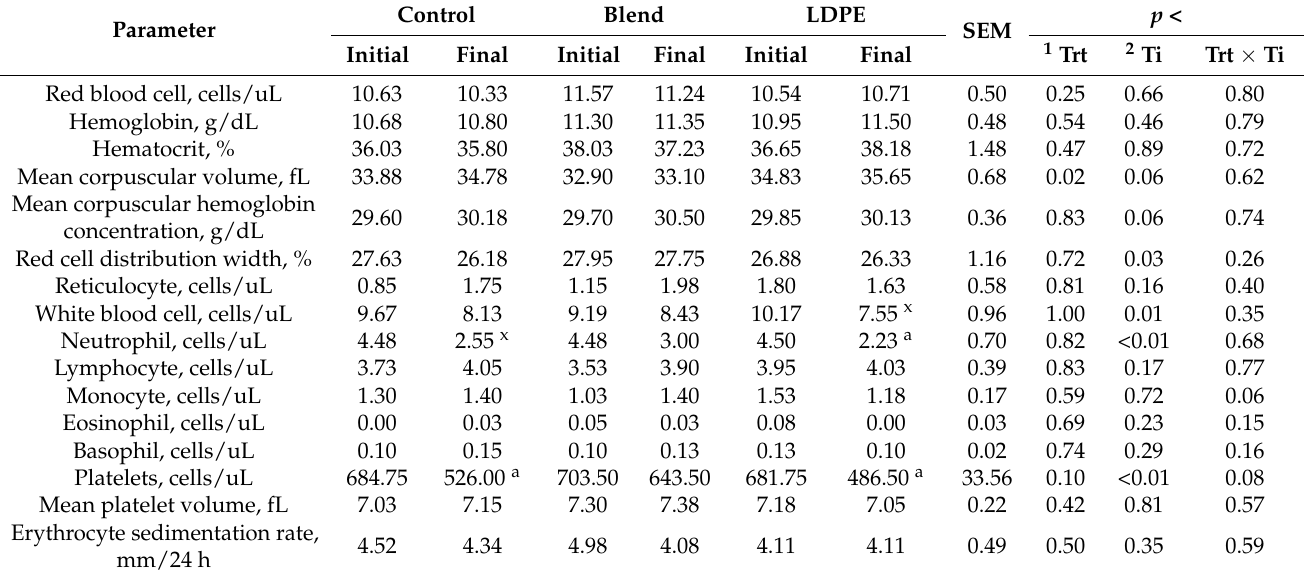
Table 1. Hematological parameters of Holstein bull calves at 0 d (Initial) and 30 d (Final) of adminis- tration of either 4 empty gelatin capsules (Control), 13.6 g of a poly(butylene succinate- co -adipate) and polyhydroxyalkanoate melt-blend in 4 gelatin capsules (Blend), or 13.6 g of low-density polyethylene in 4 gelatin capsules (LDPE).